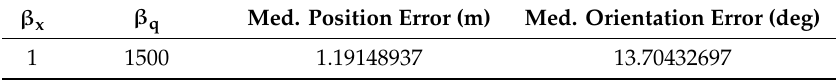
Table 10. Fine-tuning errors of the weighted Euclidean-based model (150,000 iterations).